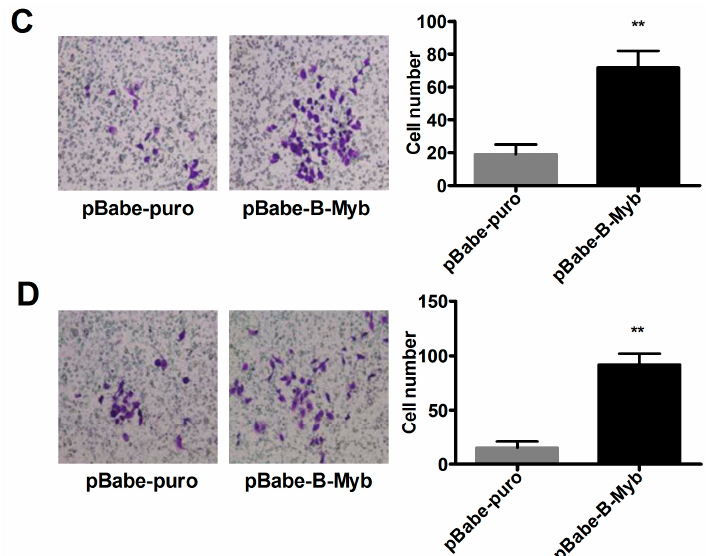
Figure 4. B-Myb overexpression increases lung cancer cell colony formation, migration, and invasion. ( A , B ) B-Myb enhances colony formation. The stable control (pBabe-puro) and B-Myb overexpression (pBabe-B-Myb) H1299 cells were seeded on plastic plates for anchorage-dependent colony formation assay ( A ) and soft agar for anchorage-independent colony formation assay ( B ), respectively. ( C ) B-Myb overexpression promotes cell migration. A Transwell migration assay was conducted with the pBabe-puro and pBabe-B-Myb stable cells in the Transwell devices without pre-coating Matrigel, as described in detail in the Materials and Methods section. Representative images (×200) (left) and quantification results (right) were shown. ( D ) B-Myb overexpression promotes cell invasion. A Transwell invasion assay was conducted with the indicated cells in the Transwell devices with pre-coating Matrigel, as described in detail in the Materials and Methods section. Representative images (×200) (left) and quantification results (right) were shown. ** p < 0.01.